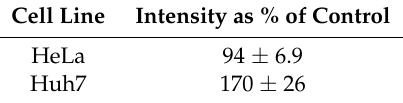
Table 2. Inhibition of alkyl-SiQD uptake after exposure to the clathrin-mediated endocytosis inhibitor chlorpromazine. The cells were pre-treated with 30 µ M chlorpromazine for 1 h and then 100 µ g mL − 1 alkyl-SiQDs and 30 µ M chlorpromazine for 24 h. The values presented are fluorescence intensities determined by flow cytometry as percentage of the control in the absence of inhibitor. (means ± SD for n = 3